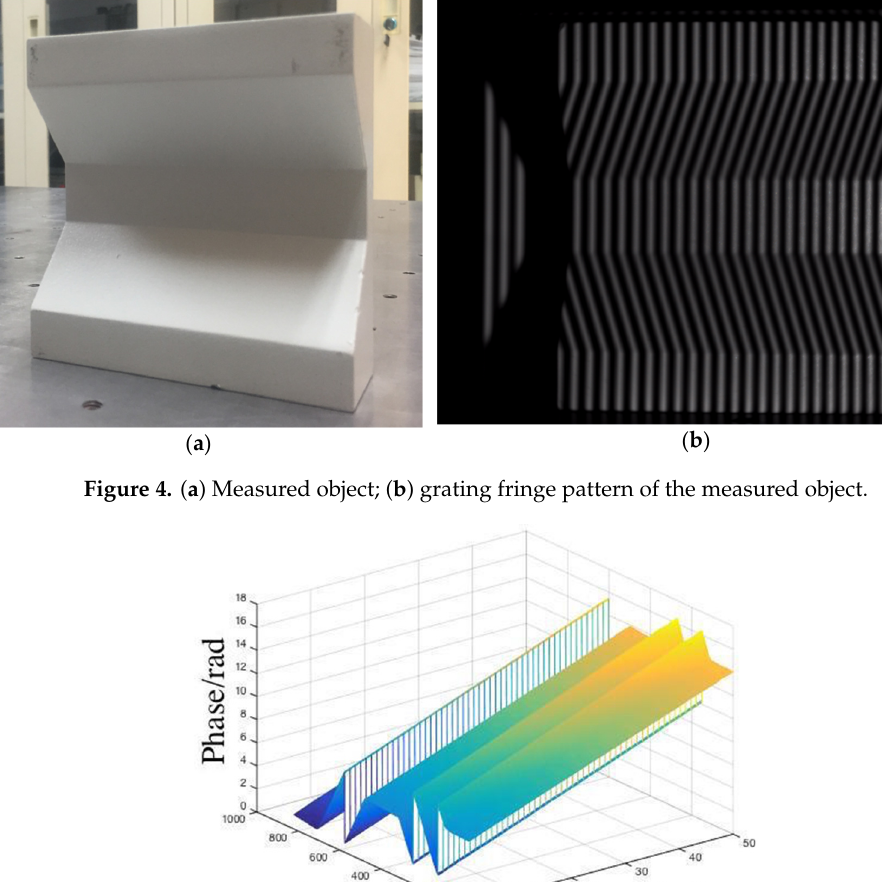
Figure 5. Phase of the measured object.